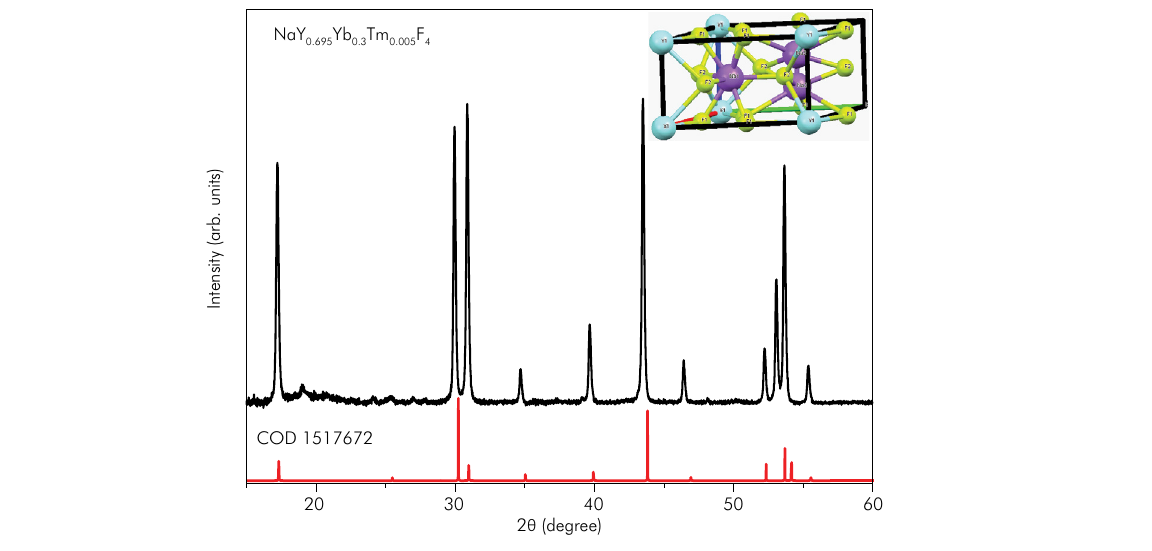
Figure 3. X-Ray diffraction pattern performed on b-NaYF of b-NaYF (COD 1517672). The spectral profile is presented as the bottom, red line. Lanthanide dopants are in the atomic sites 4 Na1 and Y1.